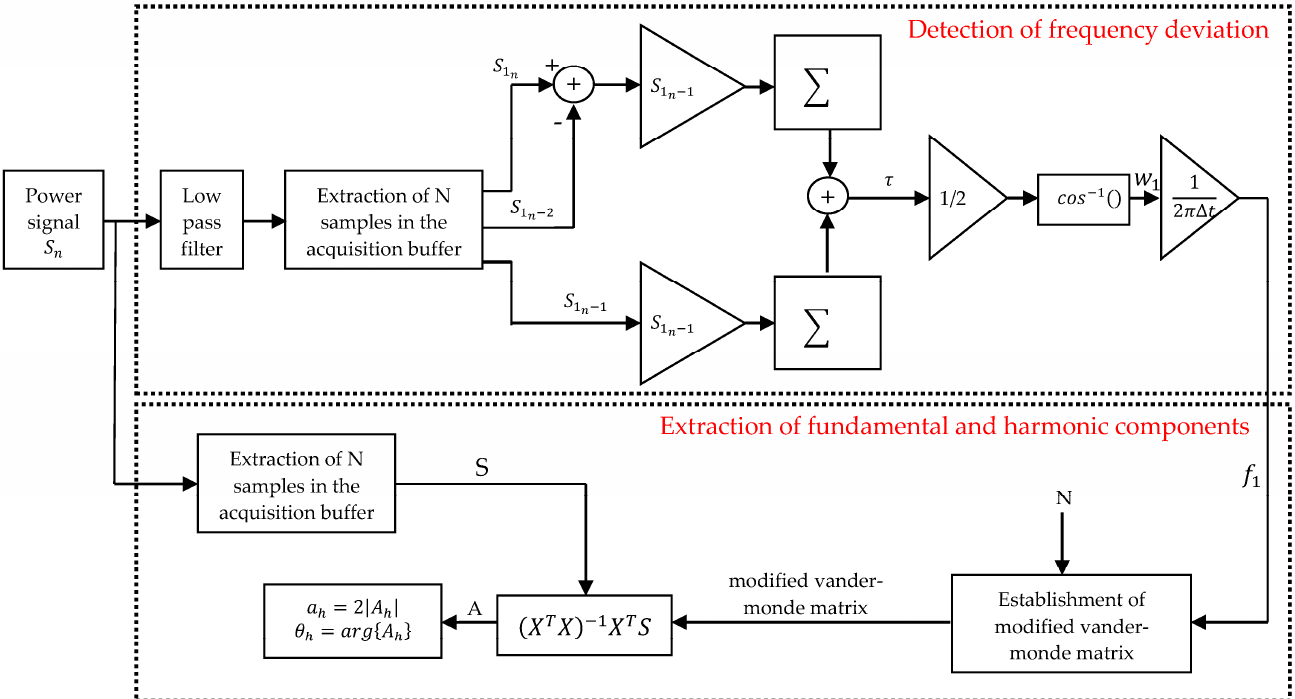
Figure 8. Solution procedure of the proposed AMS.